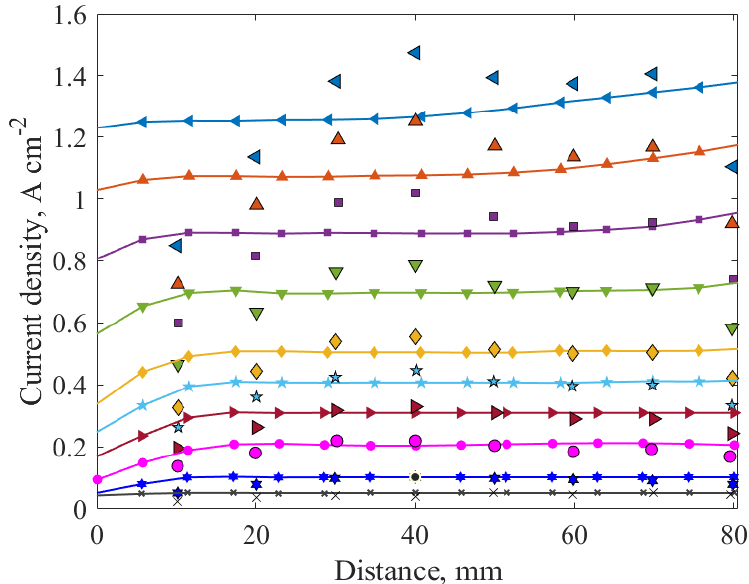
Figure 3. Local current density distribution. Predicted (lines) and experimental (points) for current densities: 1.3 Acm − 2 ( ), 1.1 A cm − 2 ( ), 0.9 A cm − 2 ( ), 0.7 A cm − 2 ( ), 0.5 A cm − 2 ( ), 0.4 A cm − 2 ( ), 0.3 A cm − 2 ( ), 0.2 A cm − 2 ( ), 0.1 A cm − 2 ( ), and 0.05 A cm − 2 ( ).